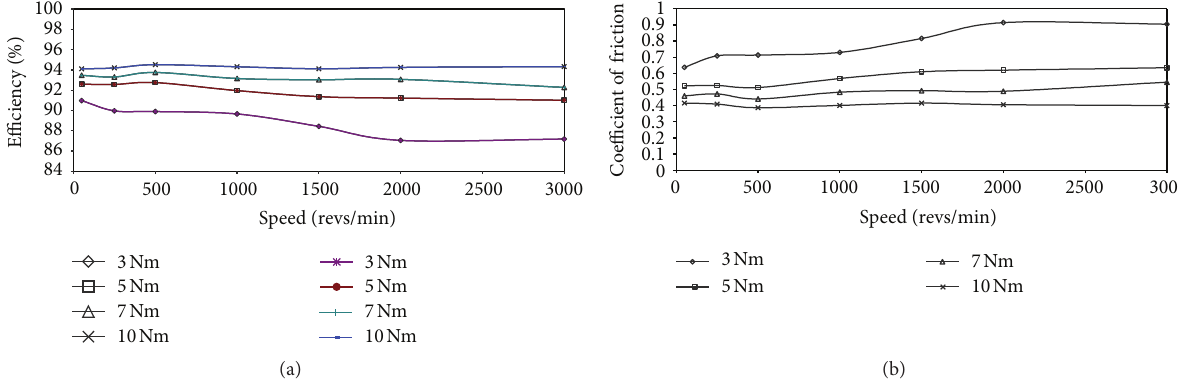
pressure angle PEEK/steel gear combinations. ∘